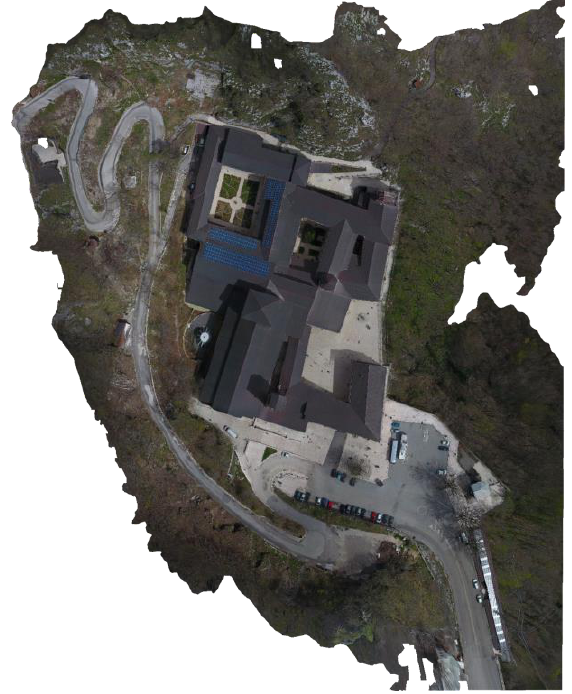
Figure 6. Zenith orthophoto of the Montevergine